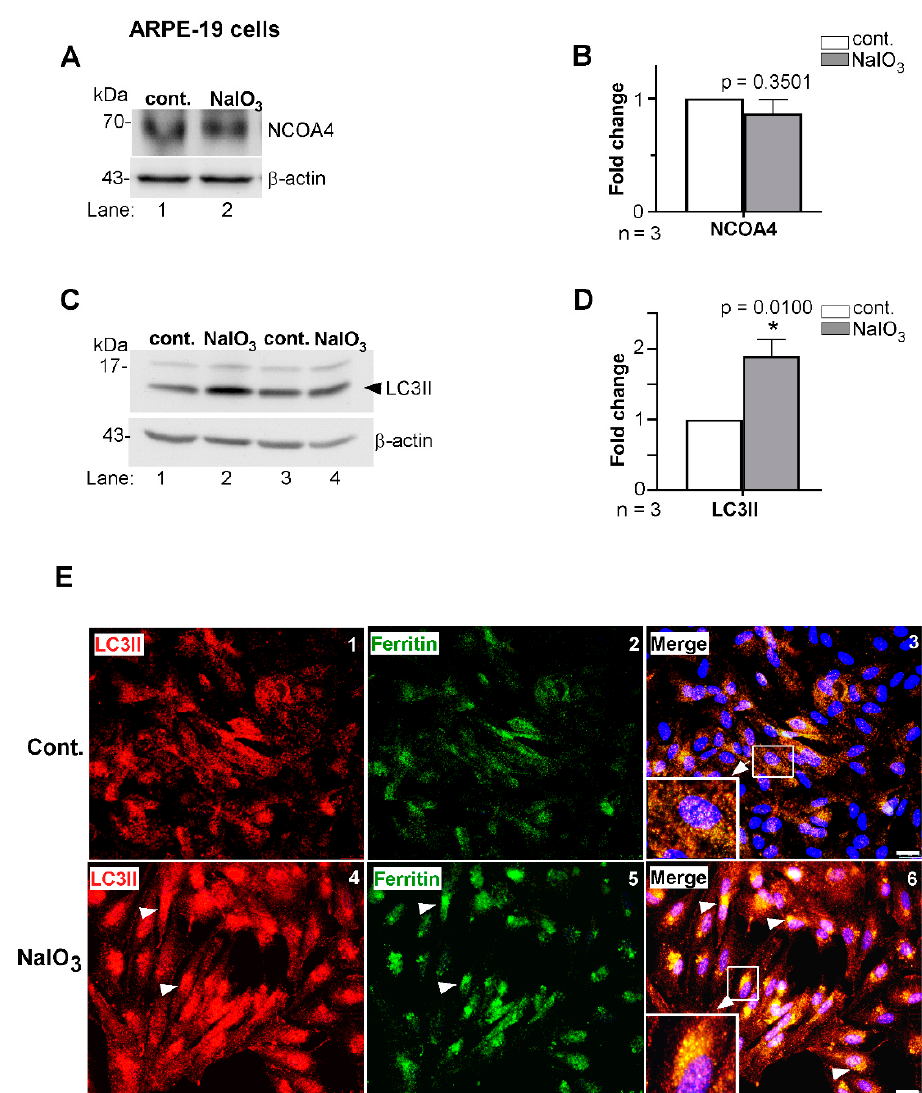
Figure 2. Ferritin accumulates in autophagosomes in NaIO 3 -treated cells. ( A ) Probing of lysates from NaIO 3 treated and control cells as above for nuclear receptor coactivator 4 (NCOA4) showed no difference in expression between the experimental and control groups (lane 2 vs. 1). ( B ) Densitometry after normalization with β -actin showed no significant change in the levels of NCOA4 in NaIO 3 - treated cells relative to controls. ( C ) Probing of lysates from a similar experimental set-up for LC3II showed increased expression in NaIO 3 -treated cells relative to controls (lanes 2, 4 vs. 1, 3). ( D ) Densitometry after normalization with β -actin showed a 2-fold increase in LC3II in NaIO 3 -treated cells relative to controls. Full blots and their details are provided in Supplementary Figure S1. Values are means ± SEM of the indicated n . * p ≤ 0.05. ( E ) Co-immunostaining of ARPE-19 cells with goat anti-ferritin and rabbit anti-LC3II followed by species-specific Alexa Fluor 488 ( green )- and Alexa Fluor 546 ( red )-conjugated secondary antibodies showed increased co-localization ( white arrows ) of the two proteins in NaIO 3 -treated cells relative to untreated controls (panel 6 vs. 3). Cells treated with only secondary antibodies showed no reaction (Supplementary Figure S2). Scale bar: 25 µ